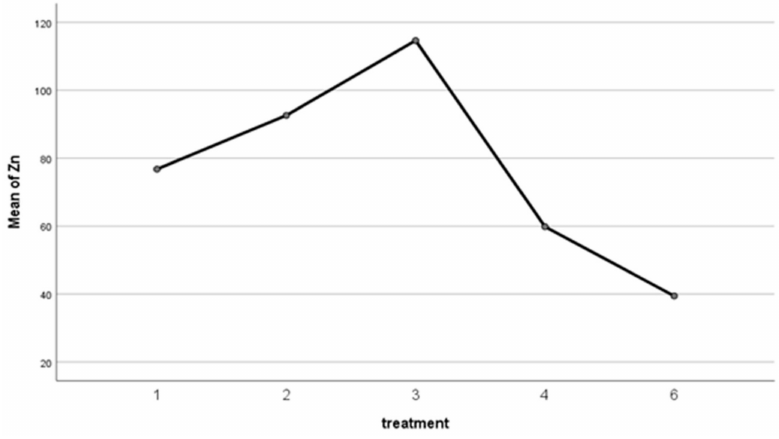
Figure 2. Average comparison. Note: unit of measure is mg × kg -1 d.m.